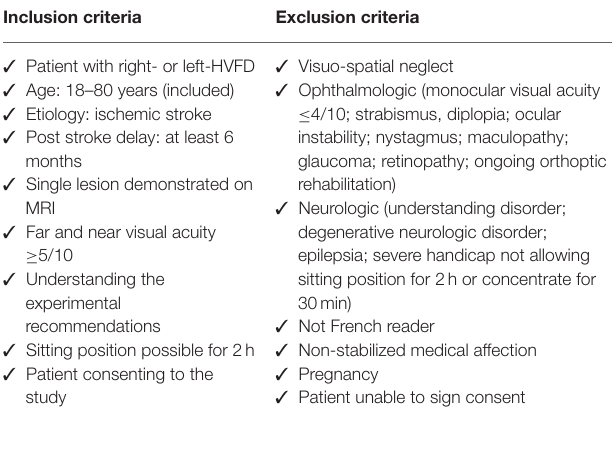
TABLE 1 | Inclusion and exclusion criteria assessed at the inclusion visit (V0).